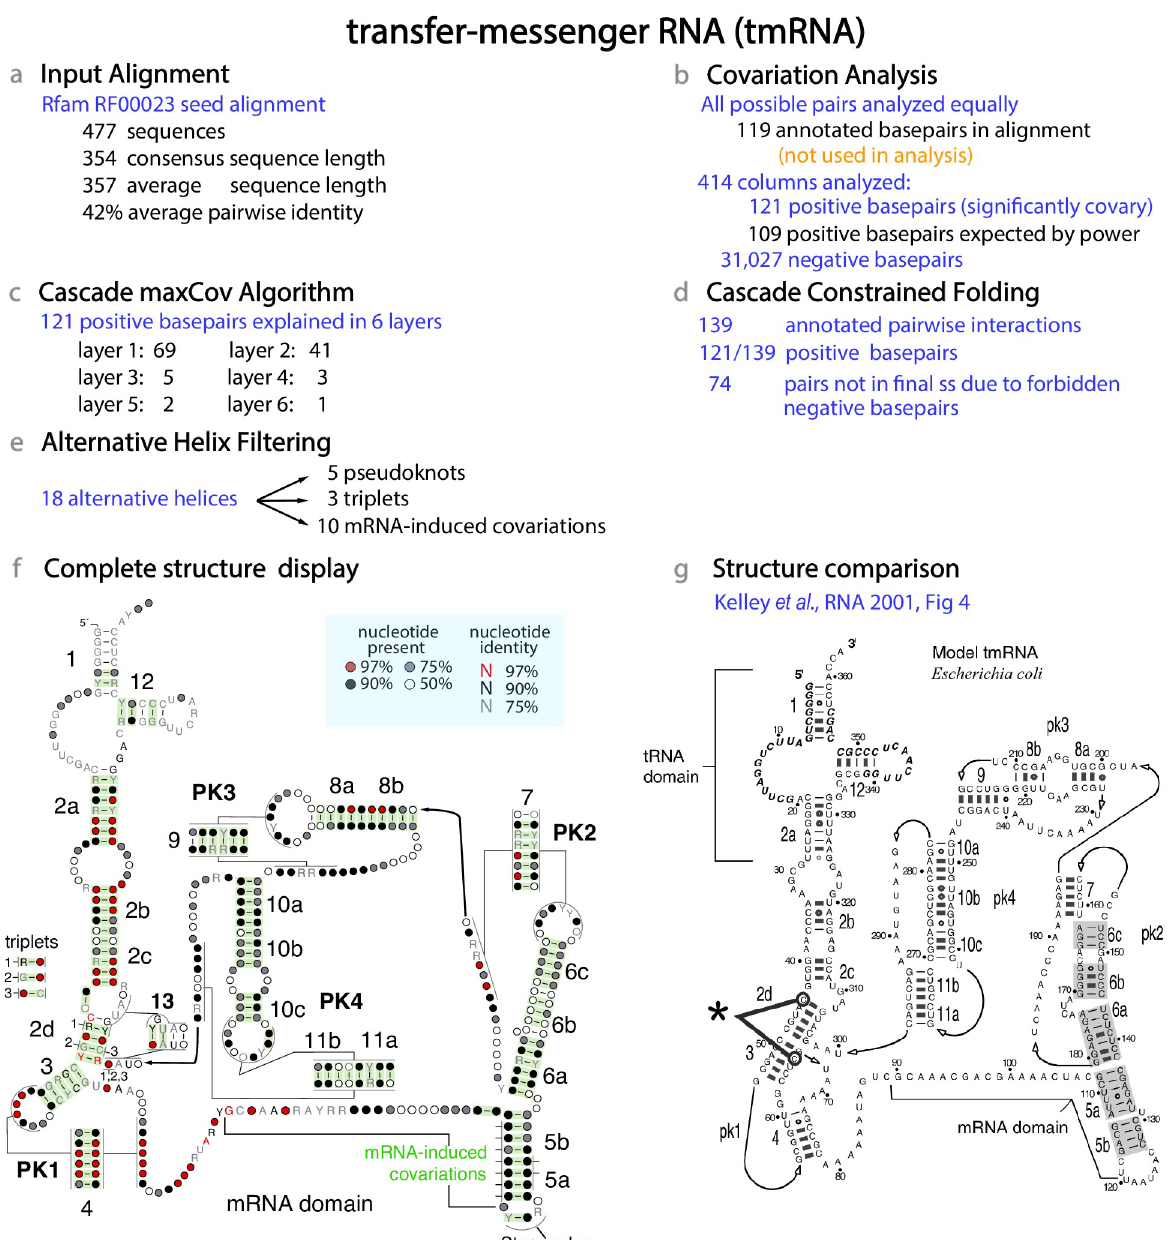
Fig 3. The CaCoFold algorithm applied to the transfer-messenger RNA (tmRNA). Steps (a) to (f) refer to the same methods as described in Fig 1. (a) Characteristics of the input alignment. (b) The statistical test that considers all possible pairs equally resulting in the assignment of 121 significantly covarying positive basepairs. The Rfam consensus structure in not used in the analysis. The whole analysis is performed using the single command R-scape --fold on the input alignment. The analysis takes 25 seconds (30s including drawing all the figures) on a 3.3 GHz Intel Core i7 MacBook Pro. (c) The maxCov algorithm requires 6 layers to incorporate all 121 positive basepairs. (d) The cascade Constraint folding completes the structure with a total of 139 basepairs. (e) After filtering, there are five pseudoknoted helices, three triplets and 10 other mRNA-induced covariations. The structural display in (f) has been modified by hand to match the standard depiction of the tmRNA secondary structure in (g) . The thick line in (g) marked with an asterisk indicates the C-C triplet interaction proposed in Ref. 44. Details of the mRNA- induced covariations are given in S6(c)